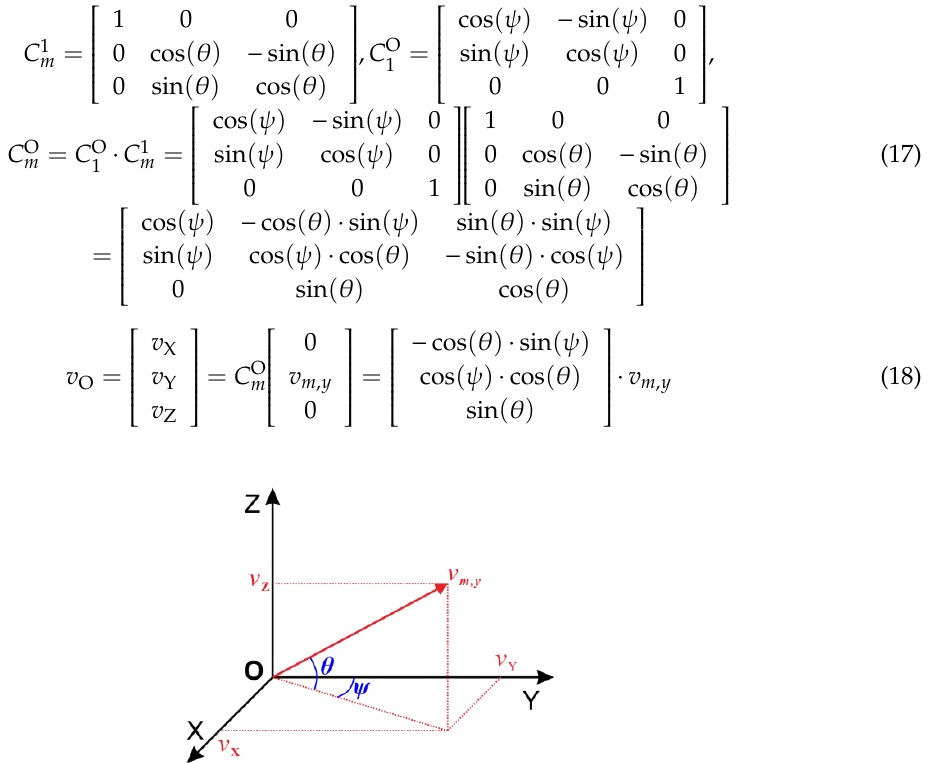
Figure 8. Geometric relationship between 𝑣 𝑂 and 𝑣 𝑚,𝑦 .